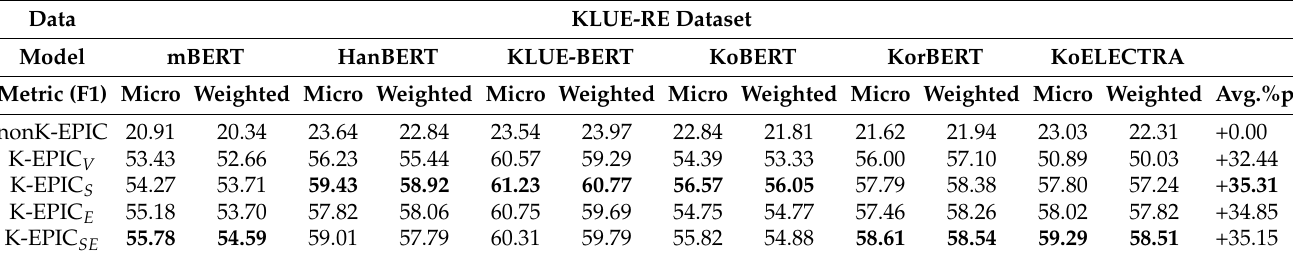
Table 5. Experimental Results on the KLUE-RE dataset on six language models within the K-EPIC method and average %p is calculated by subtracting nonK-EPIC from the average of weighted-F1 score of all of the language models (the best performing part is additionally marked in